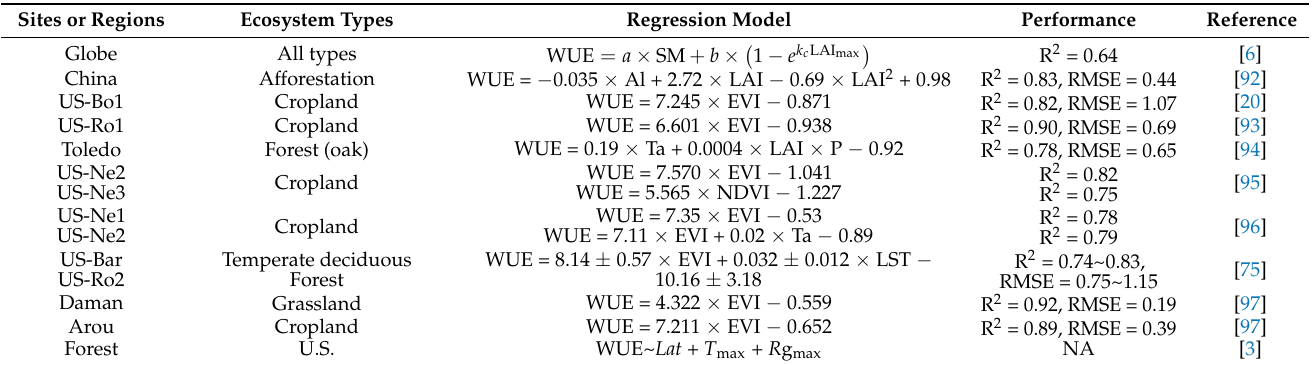
Table 4. Referenced empirical models of WUE